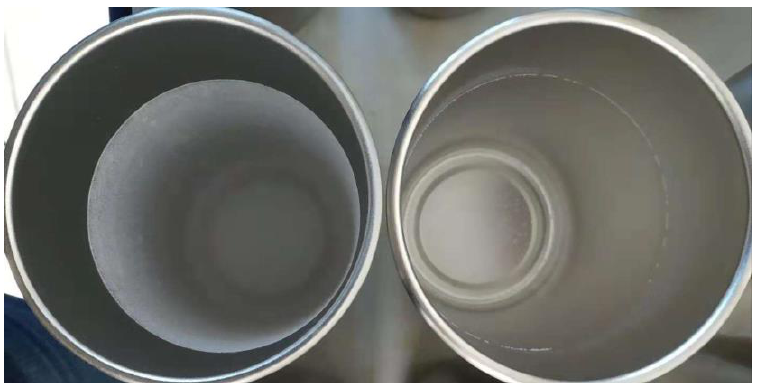
Figure 4. The image of the CaCO 3 scales attached to the experimental cup in the absence of an inhibitor (left) and in the presence of 100 mg/L carbon nanoparticles (right).